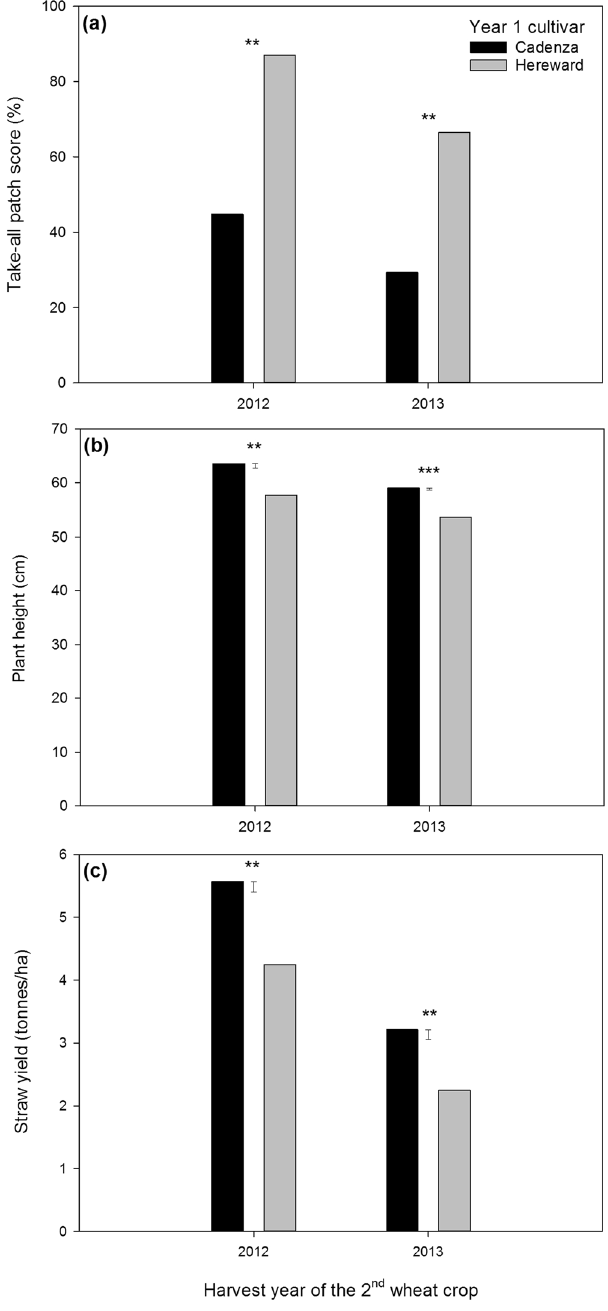
Figure 2. Take-all patch score ( a ), plant height ( b ) and straw yield ( c ) of eight winter wheat cultivars sown as a second wheat crop after the low TAB cultivar Cadenza and high TAB cultivar Hereward were sown in the first year of wheat cropping. In panel (a) the back-transformed means on the percentage scale are shown (Logit take-all patch score: 2012, Cadenza = − 0.103, Hereward = 0.939, SED = 0.141; 2013, Cadenza = − 0.427, Hereward = 0.352, SED = 0.112). Error bars in panels (b) and (c) show the standard error of the difference between the means for comparisons in each year. * Significantly different from zero at the 0.05 level of probability, ** Significantly different from zero at the 0.01 level of probability, *** Significantly different from zero at the 0.001 level of